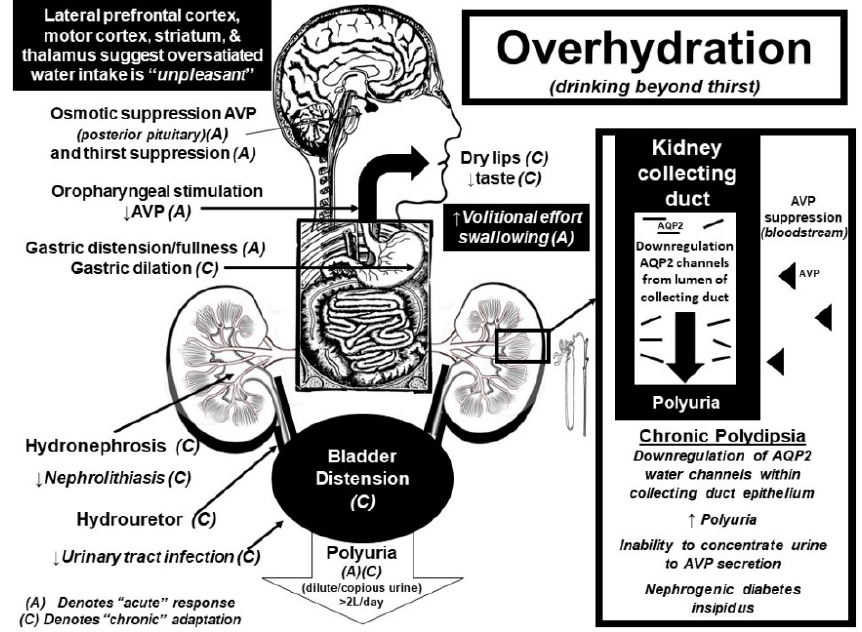
Figure 2. Summary diagram of acute (A) and chronic (C) physiological responses integrating potential pathologies and benefits associated with overdrinking in the satiated condition (above thirst stimulation).